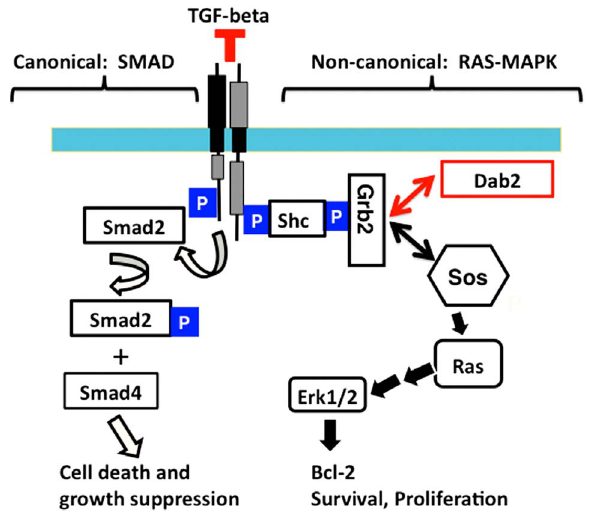
Figure 8. Schematic illustration of a working model for Dab2 in modulation of TGF-beta pathway. Canonical TGF-beta signaling pathway consists of Smad phosphorylation and mediation of transcrip- tional regulation, leading to cell death and growth suppression, representing a tumor suppressor activity. The non-canonical route includes the activation of Ras/MAPK pathway as a result of phosphor- ylation and binding of TGF-beta receptor to Shc and consequently recruitment of Grb2 and Sos. TGF-beta-stimulated activation of Ras/ MAPK pathway induces expression of genes involved in cell survival and growth. Dab2 modulates TGF-beta signaling by sequestering Grb2 from Sos, resulting in a reduction of Ras/MAPK activation yet allowing Smad- mediated gene